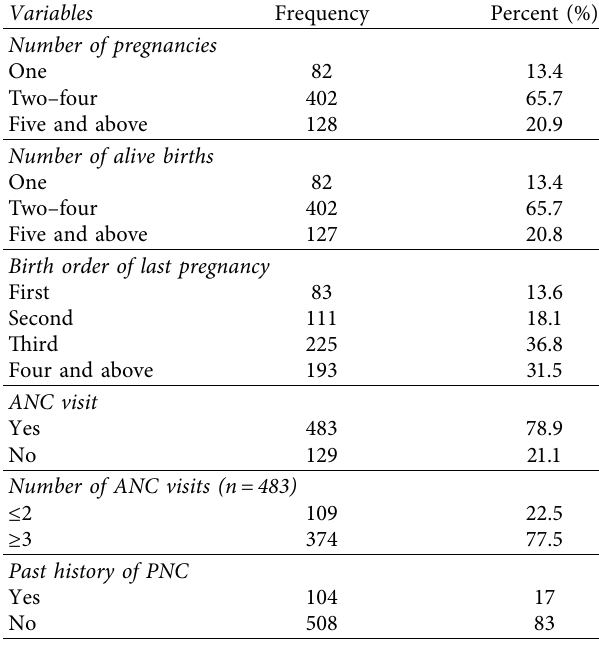
Table 1: Sociodemographic characteristics of mothers who gave birth in the last six months at Wonago District, South Ethiopia, 2017 ( n � 612).